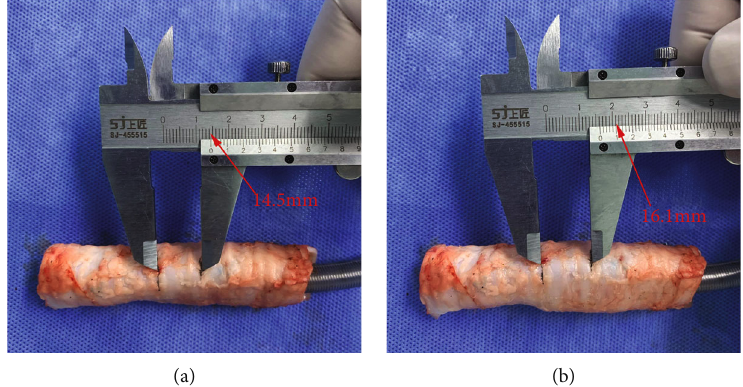
Figure 5: Variation of length of the same tracheal under di ff erent pressure of endotracheal tube cu ff (red